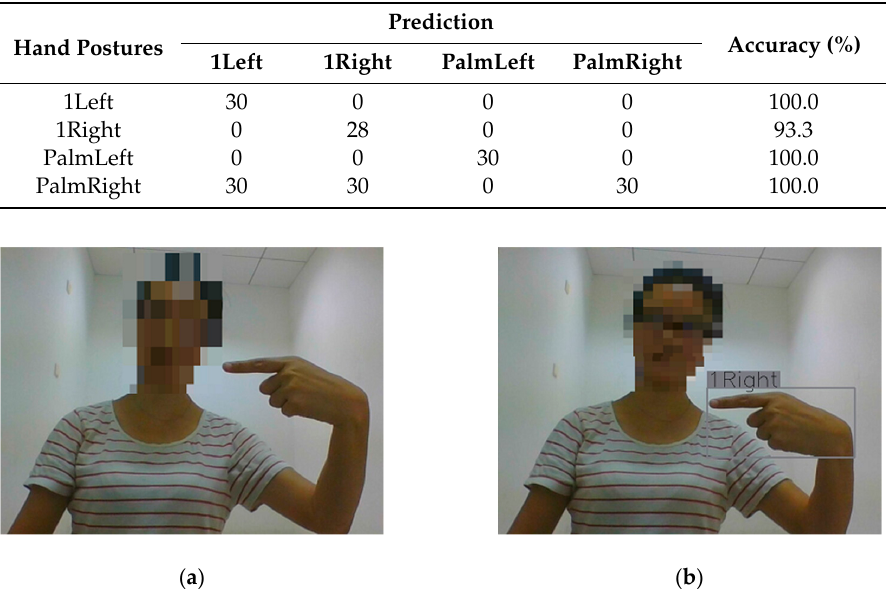
Figure 21. Example of comparison when the system correctly classifies the hand posture and when it fails. ( a ) The hand posture is not detected and recognized; ( b ) the hand posture is correctly classified.